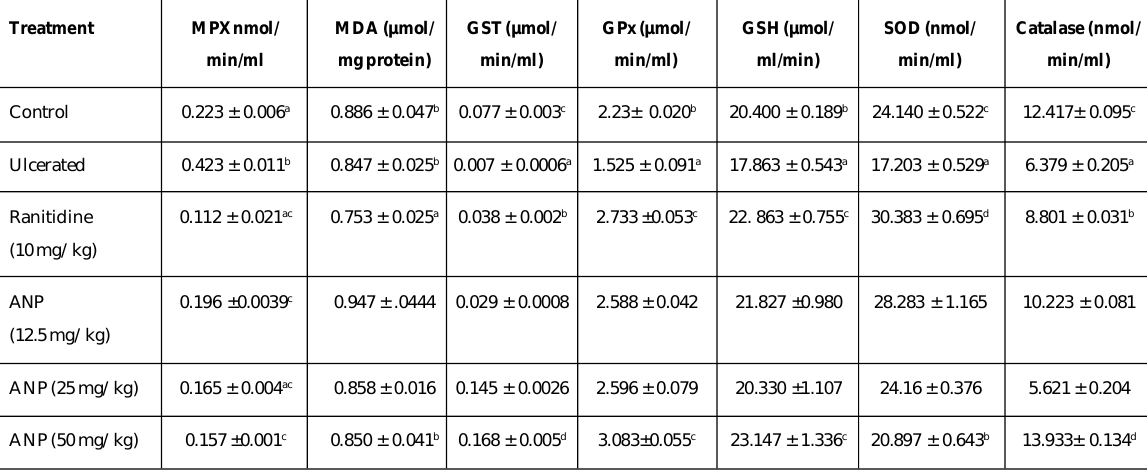
Table 4b: Effect of aqueous extract of A. nilotica seedpod on some biochemical parameters in gastric mucosa of Ethanol - Induced ulcerated rats